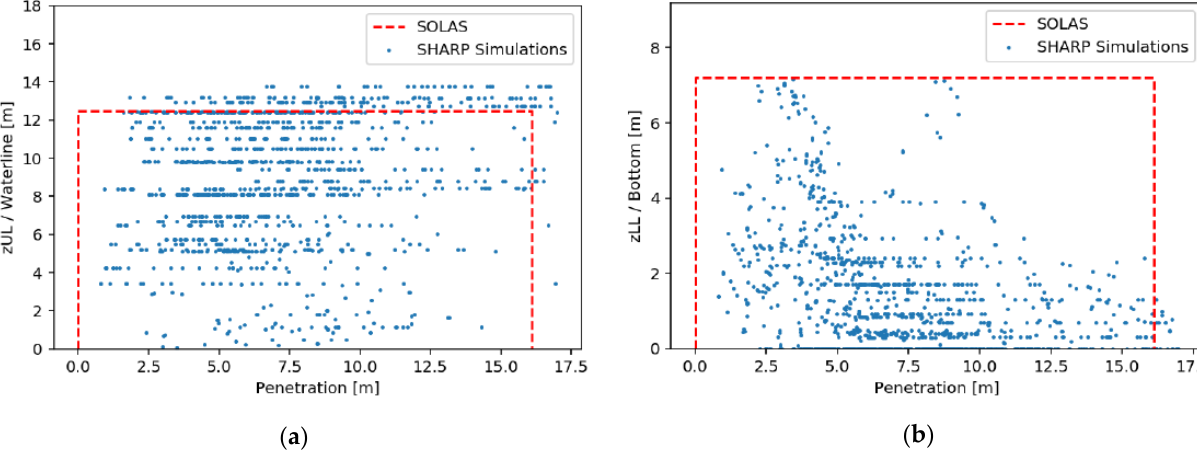
Figure 23. Damage vertical positions versus penetration for simulated damages: ( a ) upper limit; ( b ) lower limit.